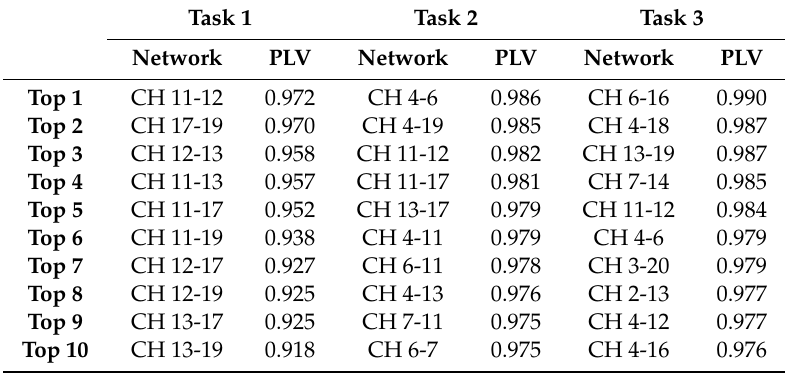
Table 21. PLVs of top 10 representing task connectivities according to channel